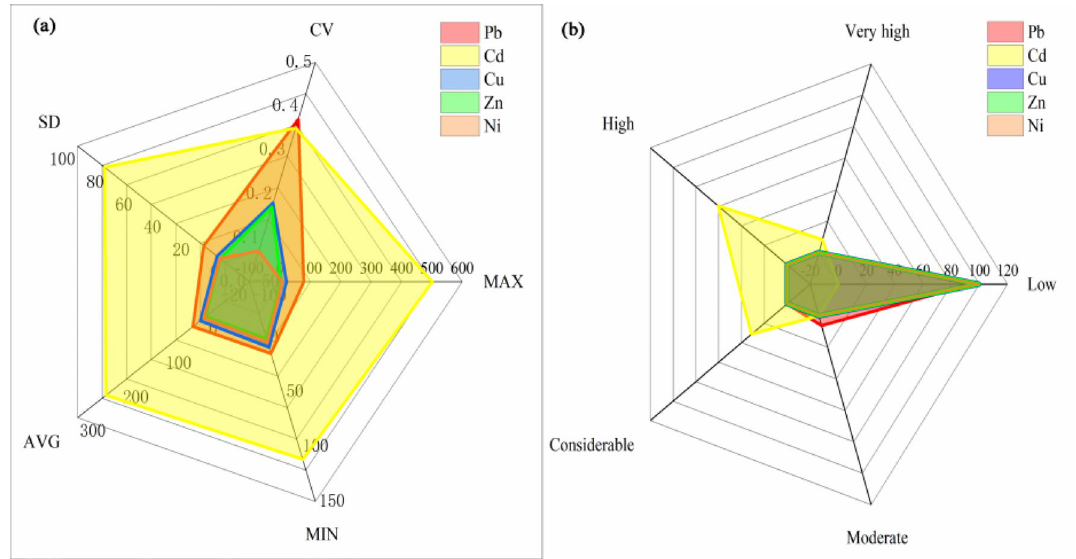
Figure 10. Statistical analysis of single factor ecological risk index. ( a ) The single factor ecological risk index of five heavy metals. ( b ) Evaluation results of the single factor ecological risk index of five heavy